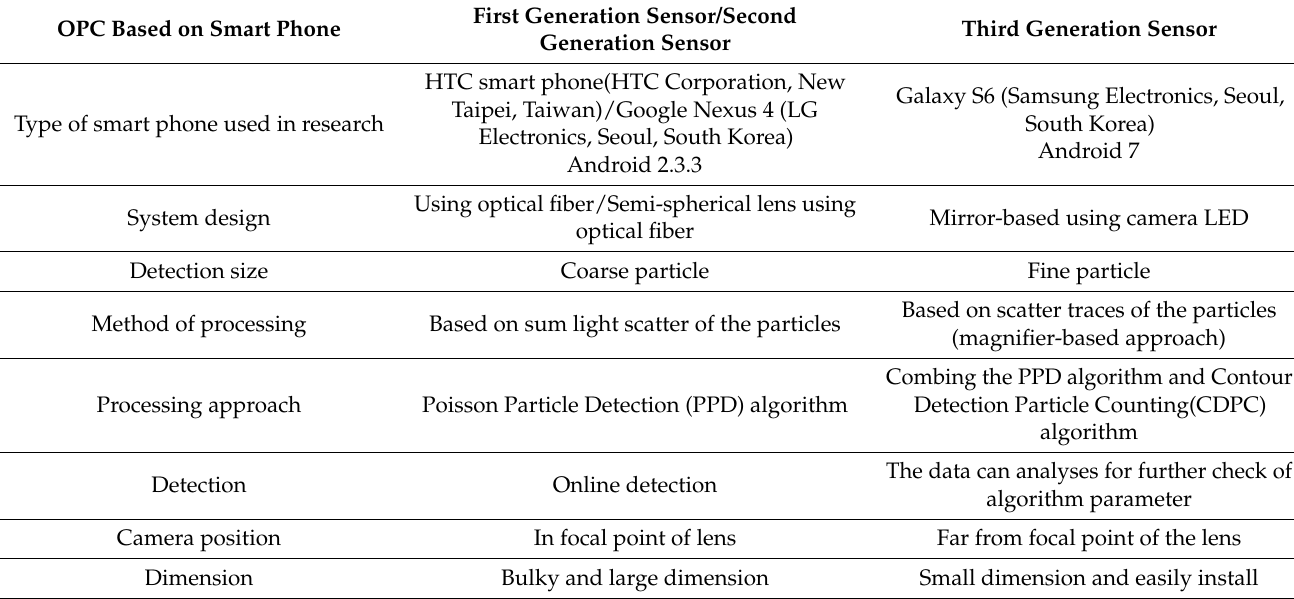
Figure 5. The total schematic of the active OPC. Adapted from ref. [66]. Table 3. Comparison of different PM sensor generation.